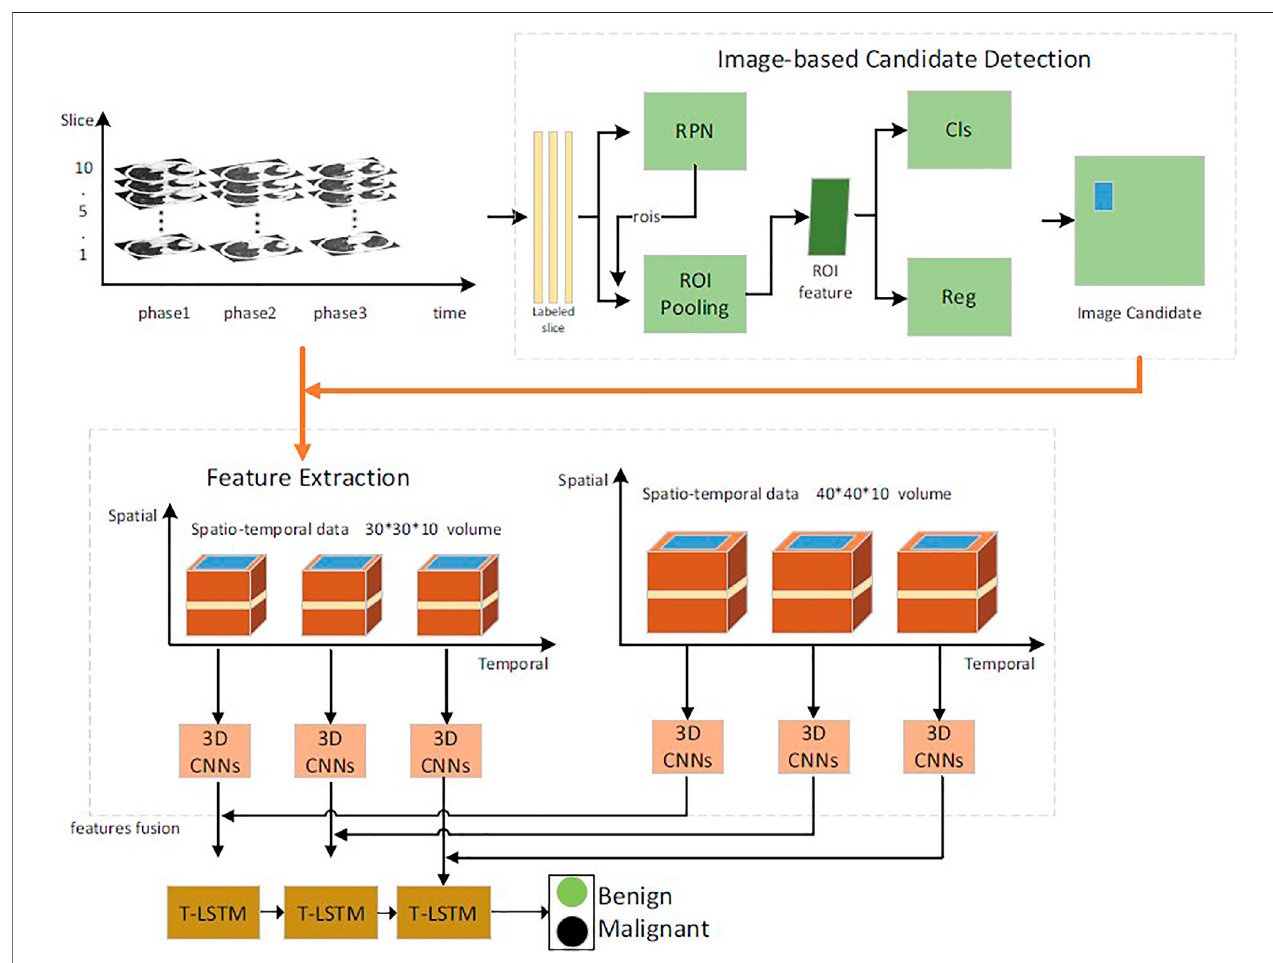
FIGURE 2 | The framework of our proposed